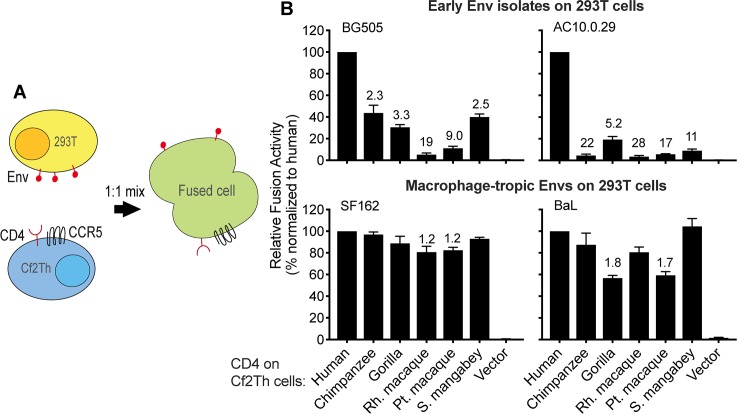
Early isolates of HIV-1 from the blood are deficient in binding and/or fusion with CD4 from some primate species.(A) 293T cells transiently expressing various Envelope proteins (Envs), and dog thymocytes (Cf2Th cells) stably expressing various primate CD4 receptors and human CCR5, were each transfected with plasmids encoding half of a split Renilla luciferase [79]. These two cell types were then cocultured to induce membrane fusion, which was detected by a luminescent product following the addition of the Renilla luciferase substrate. (B) The percentage of fusion was calculated relative to what was observed with human CD4. Error bars represent the mean + SEM from three to four independent experiments, each with four technical replicates. Values above error bars represent fold decrease relative to human CD4 for those samples that passed significance thresholds (one-way ANOVA for repeated measures effect, Dunnett’s test; P < 0.05). Data associated with this figure can be found in the supplemental data file (S5 Data). CCR5, C-C motif chemokine receptor 5.